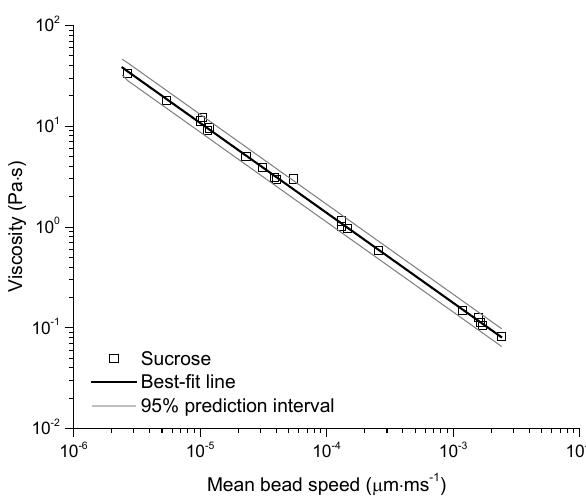
Figure 3. Calibration line (black line) and 95% prediction inter- vals (grey lines) that relate mean bead speeds to viscosity. The cal- ibration line was generated using particles consisting of sucrose (squares). Each symbol corresponds to the mean bead speed in one particle determined at the given RH. The speed of one to three beads was used to determine the mean in each